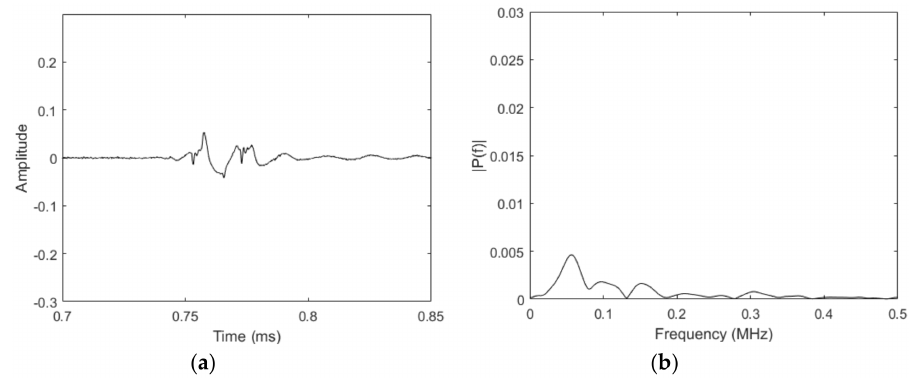
Figure 5. Acquired signal ( a ) together with its FFT ( b ) for a 50-kHz excitation with a bias magnet liftoff of 4